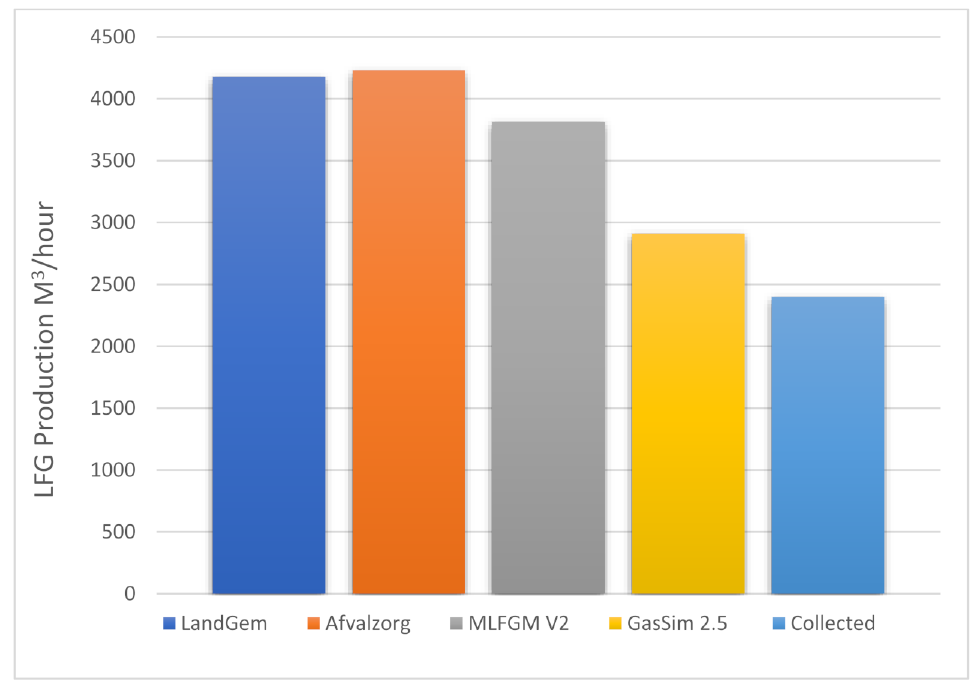
Figure 5. Comparison of the LFG modelling results with the actual collected amounts of LFG from